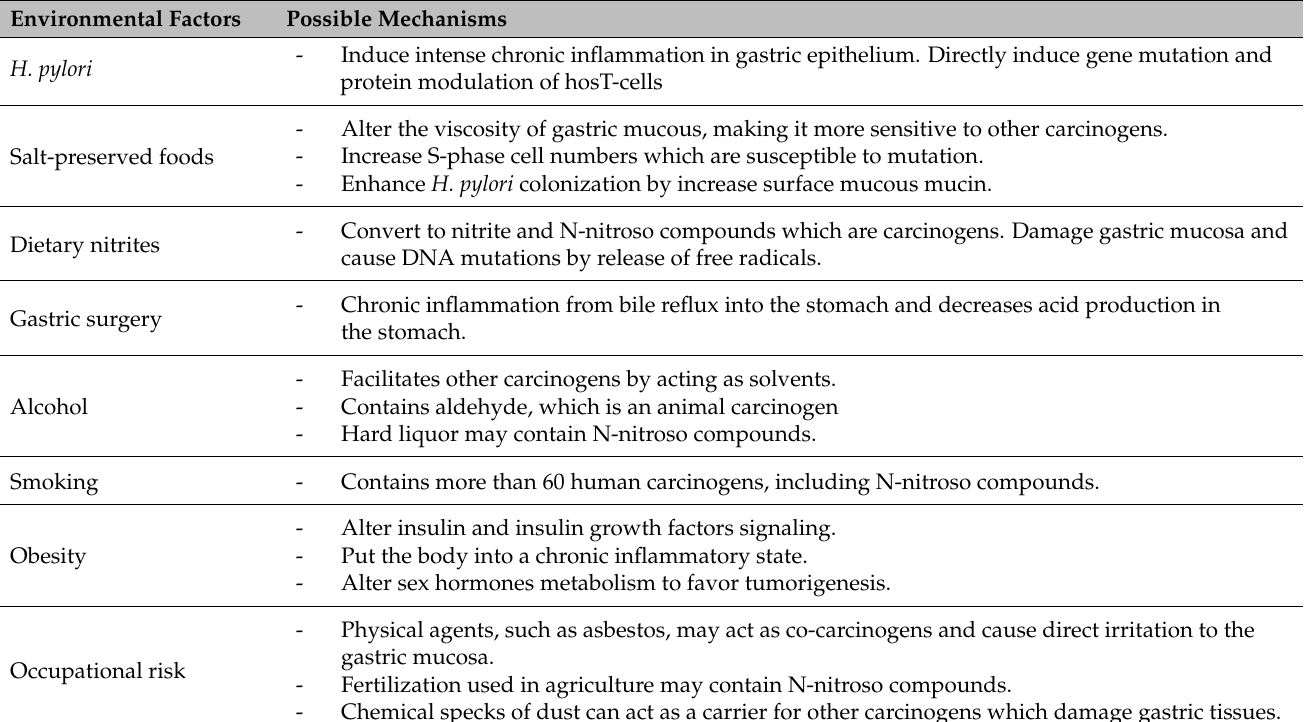
Table 1. Environmental factors related to the development of gastric